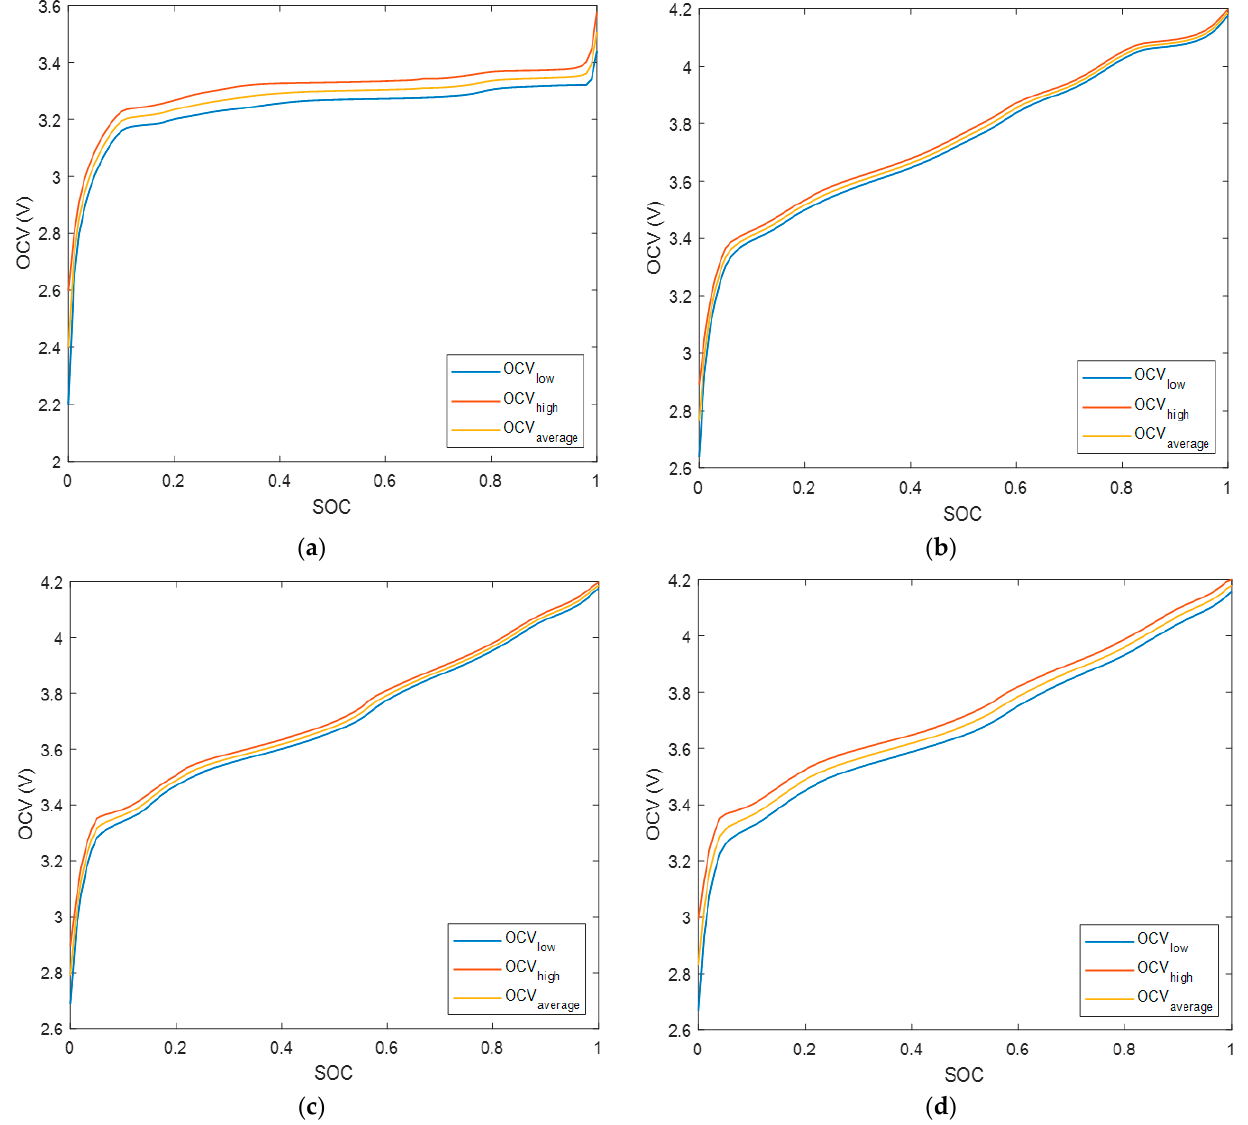
Figure 6. SOC–OCV curves for each lithium-ion battery chemistry tested: ( a ) LFP, ( b ) NMC, ( c ) LMO, and ( d ) NCA. Table 6. Model parameters obtained from HPPC data fitting in MATLAB for the LFP cell.